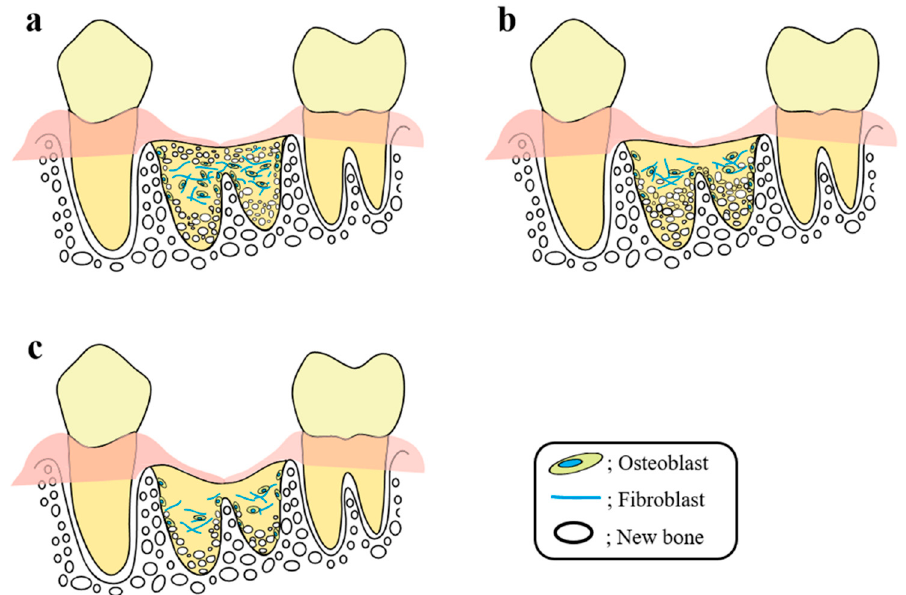
Figure 3. Differences in osteoneogenesis in tooth extraction sockets between the ( a ) CO 2 group, ( b ) diode group, and ( c ) control group. ( a ) Early in the healing process after tooth extraction, laser stimulation causes many osteoclast-like cells to appear and active bone resorption to occur from the shallow to middle layers of the extraction socket wall (activation of bone remodeling). Next, the stimulated osteoblasts produce collagen fibers associated with bone formation. These fibers form a scaffold, along which the osteoblasts migrate to form new bone. The formation of new bone is cross-linked with the collagen fiber scaffolding observed at the same site. Formation of the bone lining under the mucosa of the extraction wound prevents the depression of the mucosal epithelium and preserves the alveolar crest height. ( b ) Laser-stimulated osteoblasts present along the whole circumference of the socket produce collagen to fill the entire socket, and organization occurs at a considerably earlier stage compared with the CO 2 group. Then, fibrous granulation tissue is formed, and osteoblasts migrate to the collagen fiber to replace the granulation tissue with bone tissue. As a result, depression of the mucosal epithelium is prevented, and the alveolar crest height is preserved. ( c ) Few osteoclast-like cells are seen in the wall of the extraction socket during the early stage of healing. New bone formation in the extraction socket begins at the bottom of the extraction socket. The appearance of cells involved in bone formation is delayed compared with the laser treatment groups, and new bone formation is also delayed. As a result, the mucosal epithelium around the extraction wound invades the extraction socket and a concavity forms at the center of the alveolar crest with a corresponding decrease in alveolar crest height. Reproduced from [12] under Creative Commons CC BY-NC